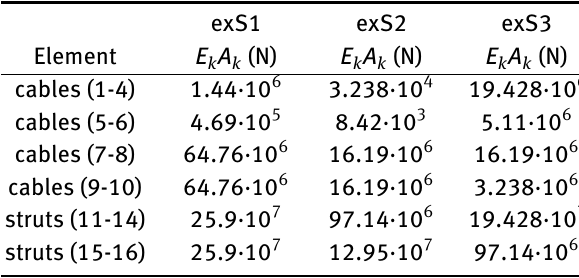
Table 4: Axial stiffness of the elements of the Snelson’s X beam with three modules which lead to the results obtained in the